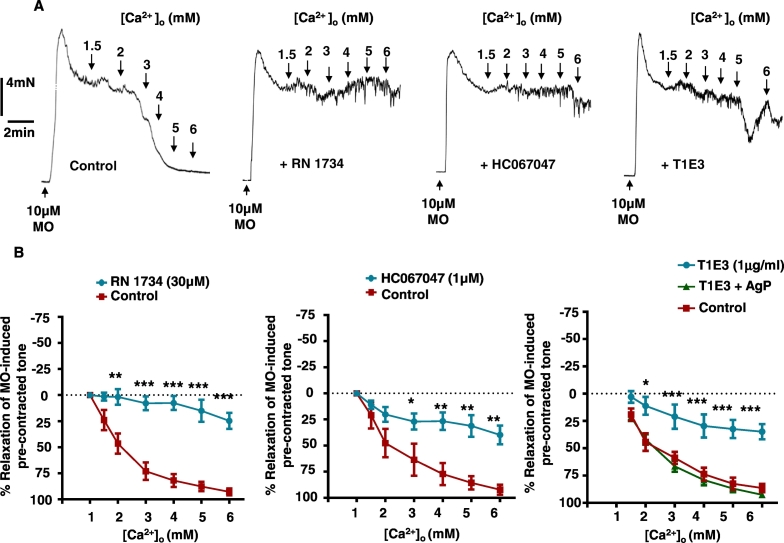
Effect of TRPV4 and TRPC1 blockers on [Ca2 +]o-induced relaxation in rabbit mesenteric arteries.A Representative traces and B, mean data showing the inhibitory effect of the TRPV4 antagonists RN1734 and HC067047, and the TRPC1 blocker T1E3 on [Ca2 +]o-induced relaxations of pre-contracted tone. Pre-incubation of T1E3 with AgP prevented the inhibitory action of TIE3. n = 5 animals, 3 vessel segments per animal.